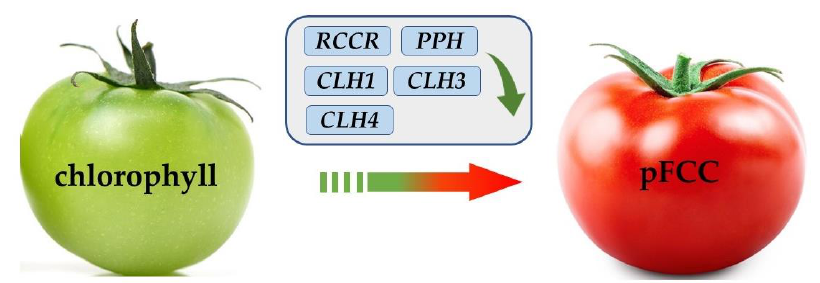
Figure 4. Mechanism of chlorophyll metabolism.